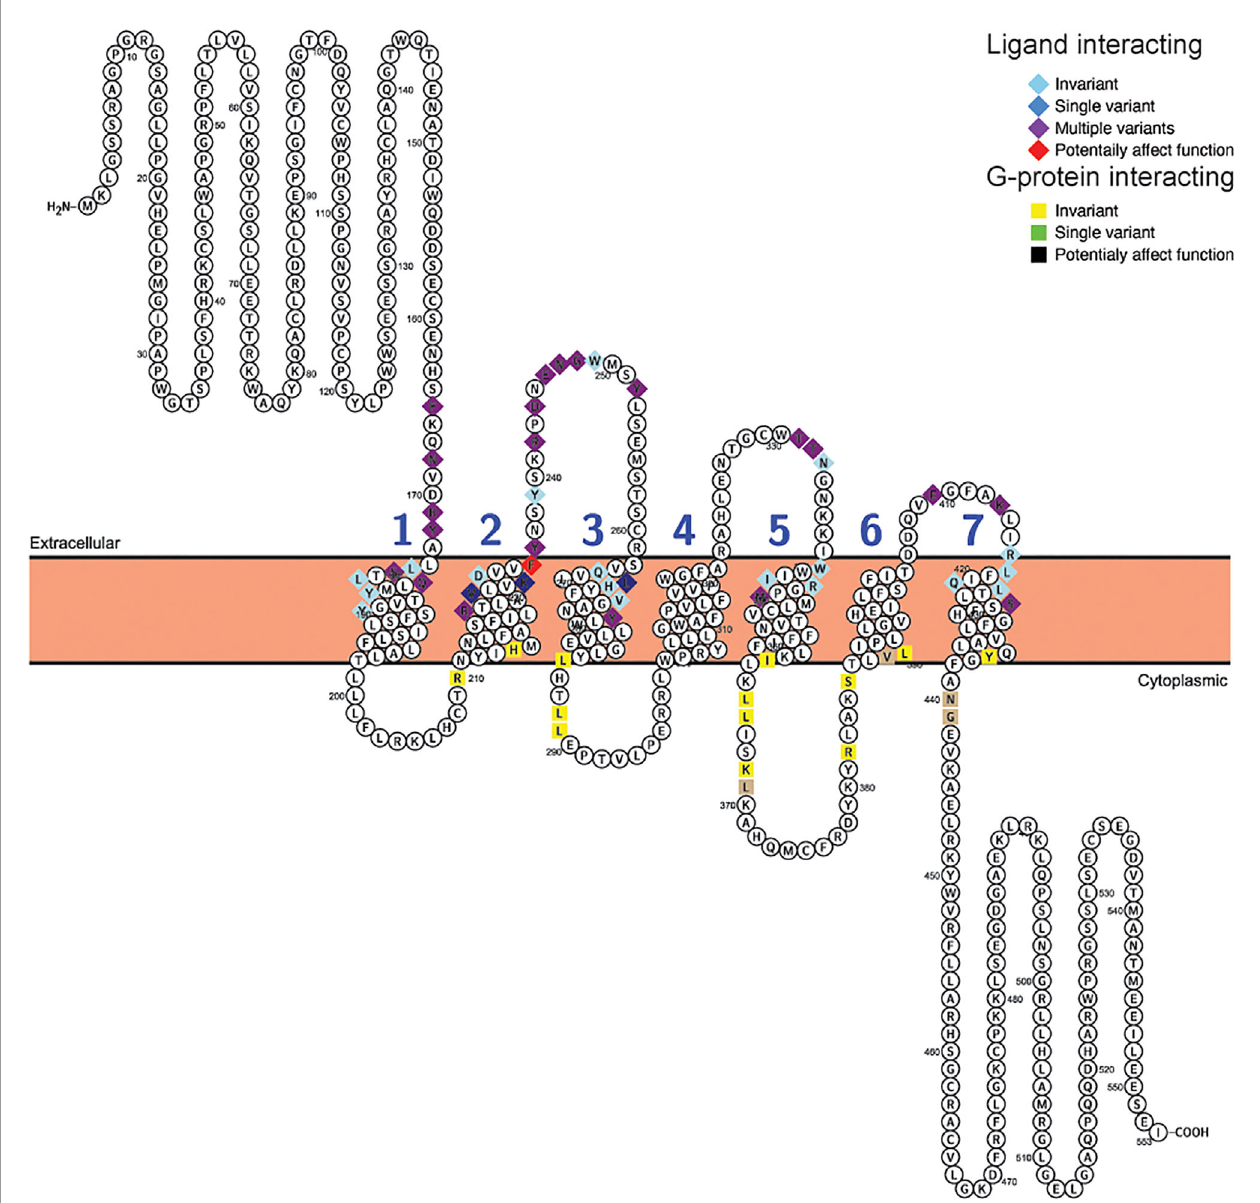
FIGURE 5 | Variability in ligand and G-protein interacting sites in mammalian GLP-2 receptors (Glp2r). Snake plot of the Gcgr protein sequences (Uniprot accession: GLP2R_HUMAN) generated with Protter (wlab.ethz.ch/protter/start/) (71). Extracellular regions are shown at the top, cytoplasmic regions at the bottom, and transmembrane domains between the two lines. Transmembrane domains are extracted from the Uniprot accession fi les for the proteins by Protter. The transmembrane domains are numbered (1-7). Ligand interacting residues are shown as diamonds and G-protein interacting sites as squares. Variability in the ligand and G-protein interacting residues in the sequences from 78 mammalian species are displayed in different colors with light blue diamonds and yellow squares being invariant, dark blue diamonds only have one species varying, purple diamonds and tan squares representing sites that either vary in multiple species and/or have multiple amino acid states, while red diamonds identify sites that have a substitution that was predicted to “ Affect function ” by SIFT (67) and be “ Deleterious ” by PROVEAN